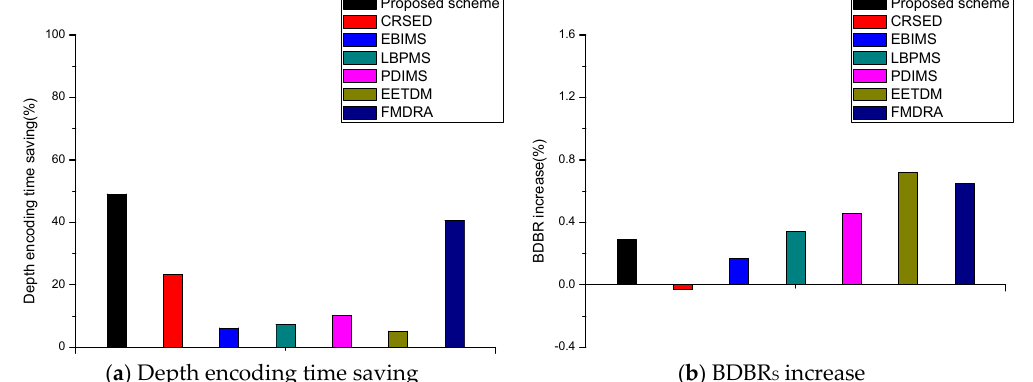
Figure 6. Coding results of the proposed scheme and five algorithms under the “Random Access” configuration.